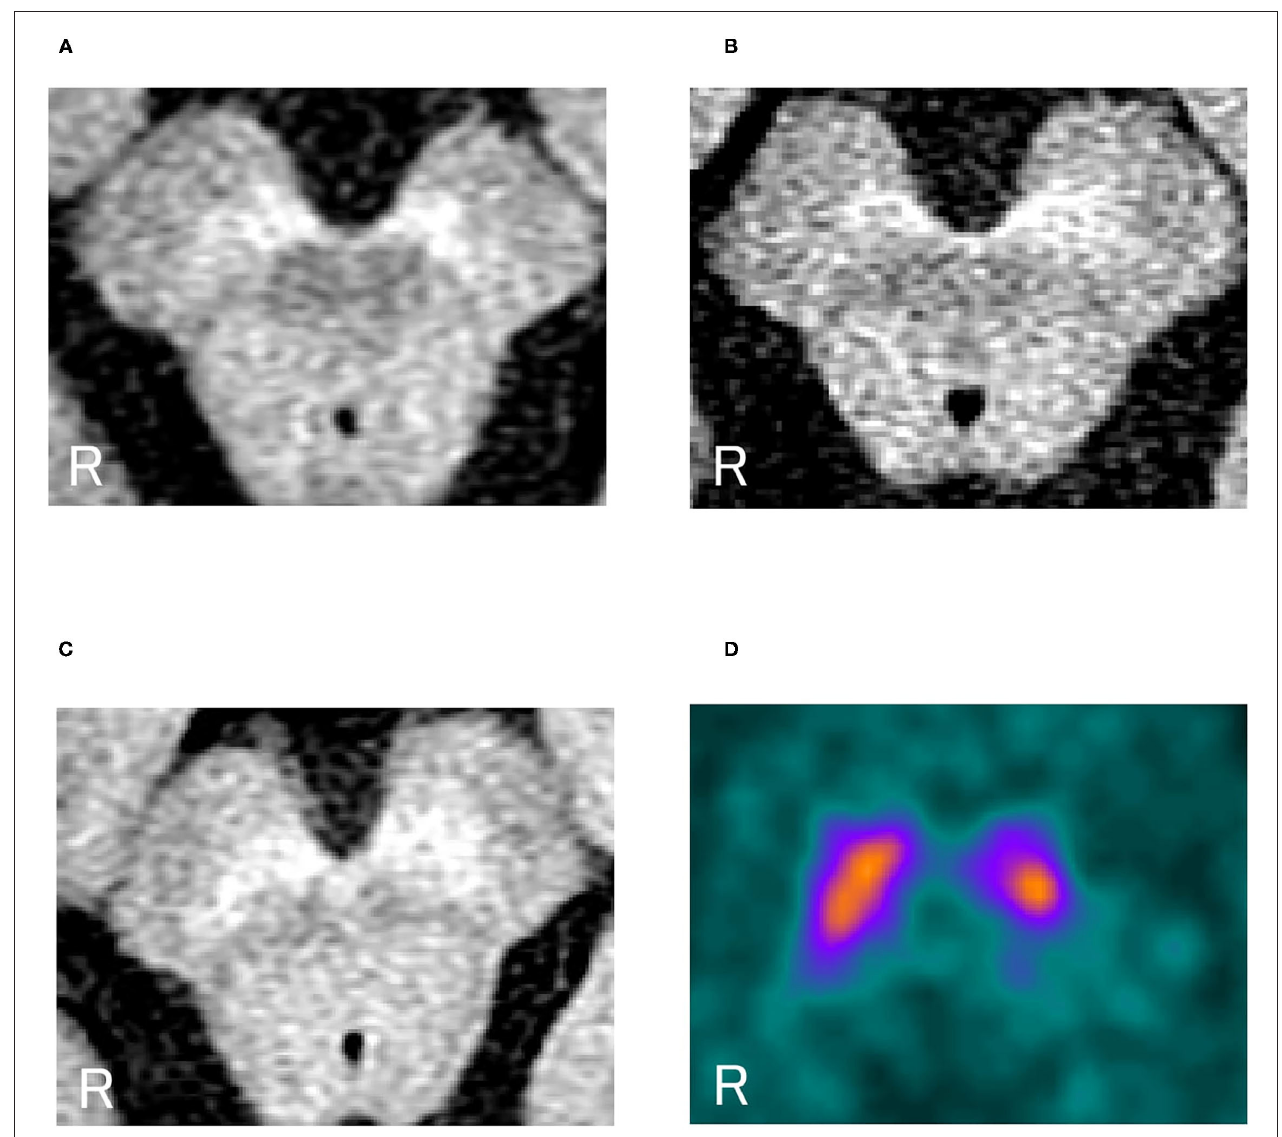
FIGURE 1 | (A) Neuromelanin-sensitive magnetic resonance imaging in a representative dystonia case (a patient with DYT- SGCE ). (B) NM-MRI in a representative PD case. (C) NM-MRI in a representative control case. (D) DAT SPECT in a representative case of a female patient with dystonia (DYT- SGCE ). Her cSBR was 4.79/3.33. Her age-estimated cSBR was 8.40. The 95% lower limit of prediction intervals on the cSBR for 50–59 years was 5.95. NM-MRI, neuromelanin magnetic resonance imaging; DYT- SGCE , dystonia -epsilon sarcoglycan gene; PD, Parkinson’s disease; DAT SPECT, dopamine transporter single-photon emission contrast tomography; cSBR, calibrated specific binding